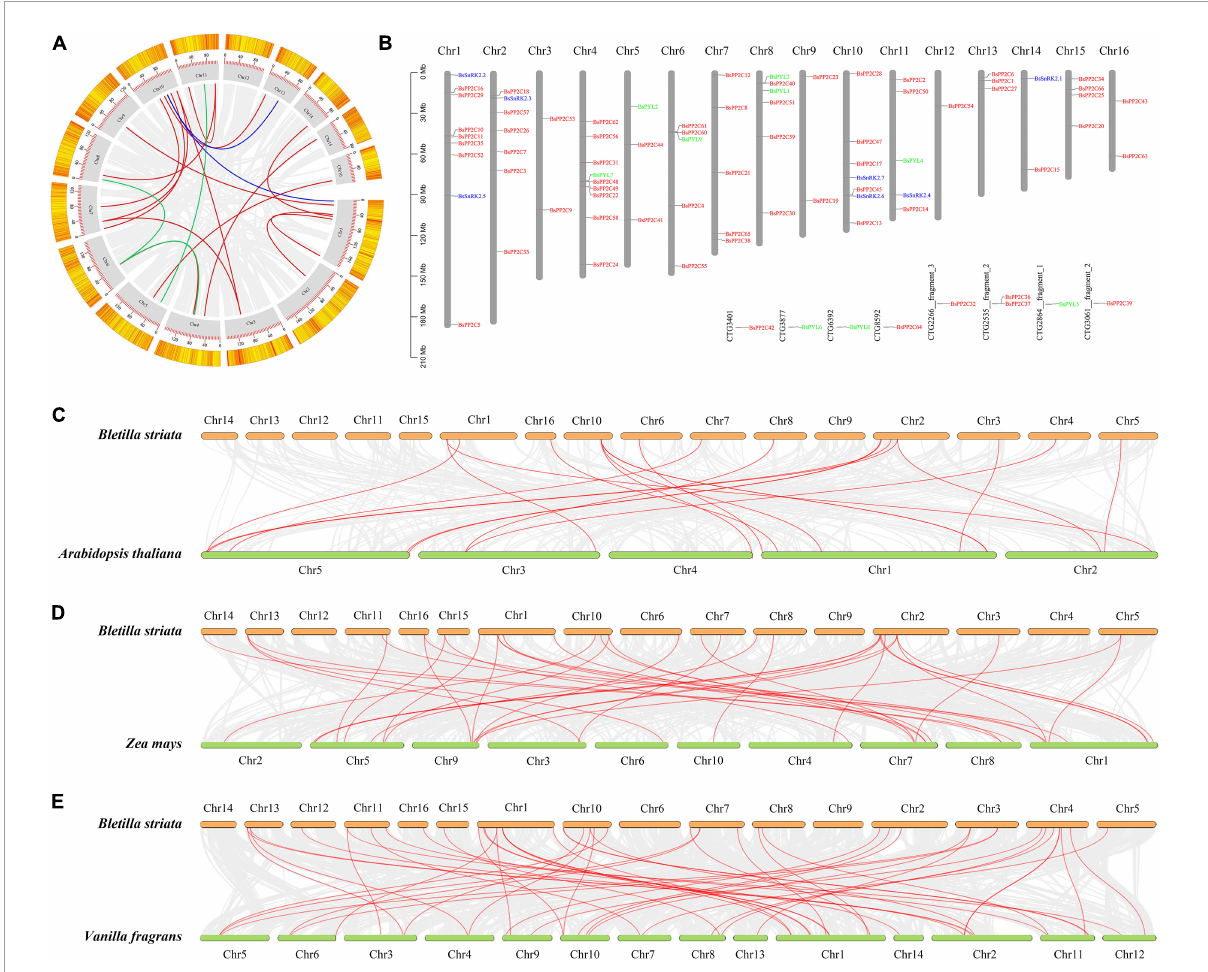
FIGURE3 Chromosomal localization and collinearity analysis of BsPP2Cs, BsPYLs, and BsSnRK2s gene families. For intraspecific collinearity analysis (A) and chromosomal localization (B) , gray boxes (gray columns in panel B ) represent the 16 pseudochromosomes of B. striata , and red, green, and blue lines represent collinear relationships and localization in BsPP2Cs, BsPYLs, and BsSnRK2s gene families, respectively. Interspecific collinearity analysis of BsPP2Cs, BsPYLs, and BsSnRK2s between B. striata and A. thaliana (C) , Z. mays (D) , as well as V. fragrans (E) . Red lines represent collinear relationships of orthologous gene